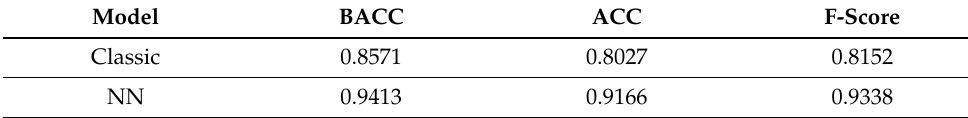
Table 7. Summary of results from our Experiment